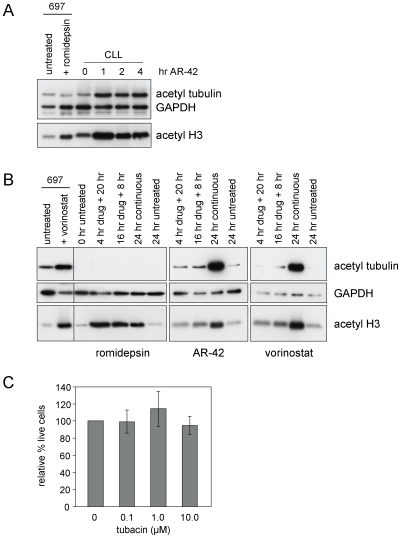
AR-42 exhibits class I and II DAC inhibitory activity.(A) CLL cells were incubated with or without AR-42 (0.90 µM) for the times noted. Lysates from 697 cells incubated 16 hr without or with 0.04 µM romidepsin were included as controls. Extracts were analyzed by immunoblot for acetylated tubulin and histone H3, plus GAPDH as a loading control. Data are representative of six patient samples. (B) CLL tumor cells were incubated with or without DAC inhibitors romidepsin (0.04 µM), AR-42 (0.90 µM), or vorinostat (5.0 µM) as indicated. 697 cells incubated 24 hr with or without 5.0 µM vorinostat were included as a control (left). Extracts were analyzed by immunoblot for acetylated tubulin and histone H3, plus GAPDH as loading control. Data are representative of seven CLL samples. (C) CLL patient cells (n = 4) were incubated without or with tubacin as indicated for 72 hr, and viability was analyzed by MTT assay. Data are shown relative to the time-matched untreated control. There were no significant changes in viability across doses (p = 0.265).